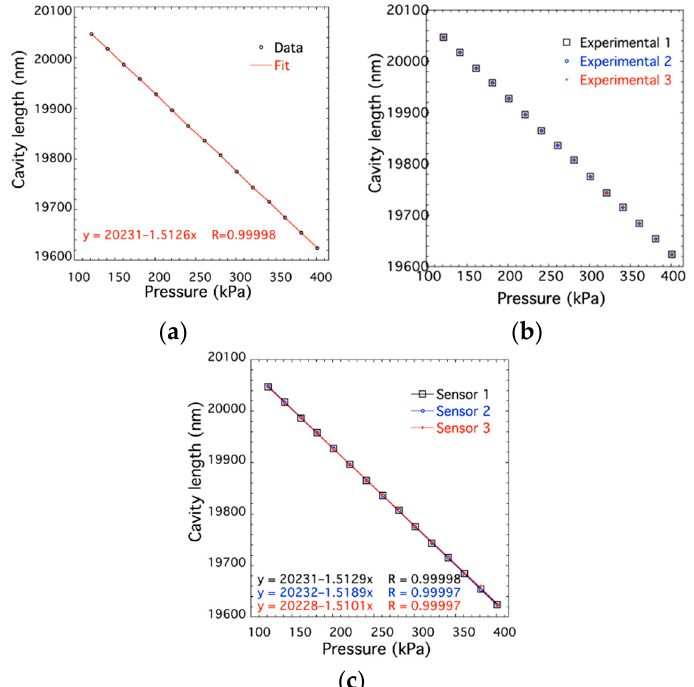
Figure 9. Calibration of the cavity length and the pressure applied on the sensor to test the ( a ) linearity, ( b ) repeatability, and ( c ) consistency.